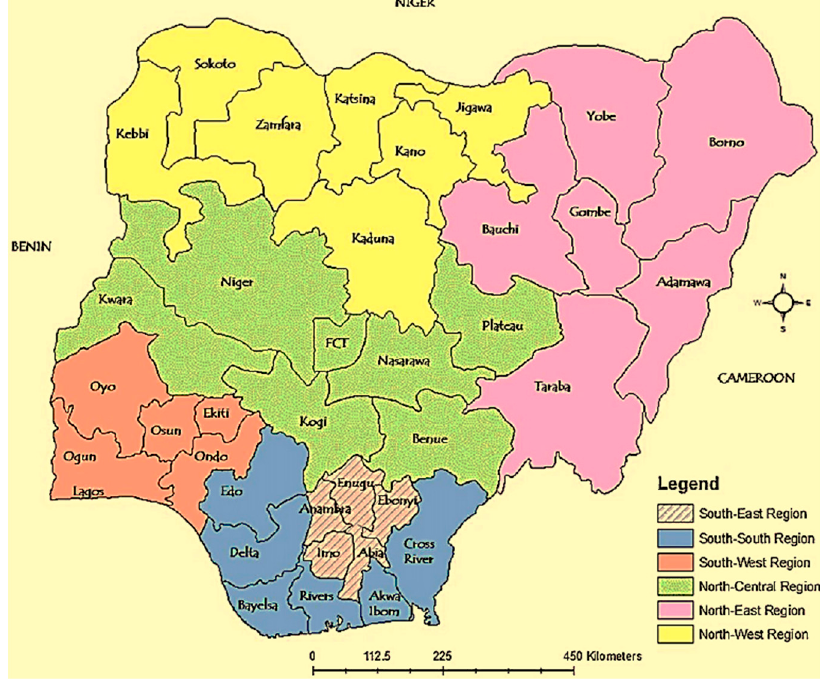
Figure 1. Mapping of the six geopolitical zones in Nigeria (google.com.ng).